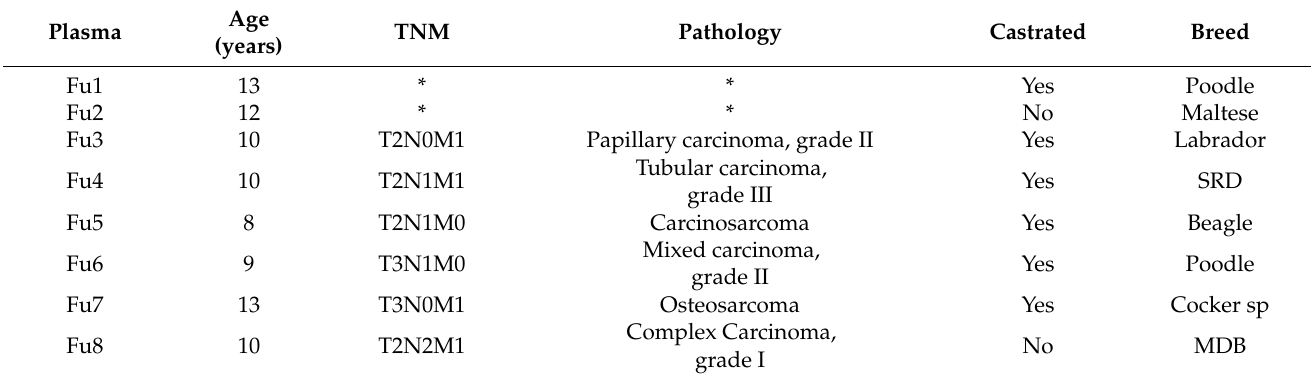
Table 6. Histopathological data of follow-up female dogs with